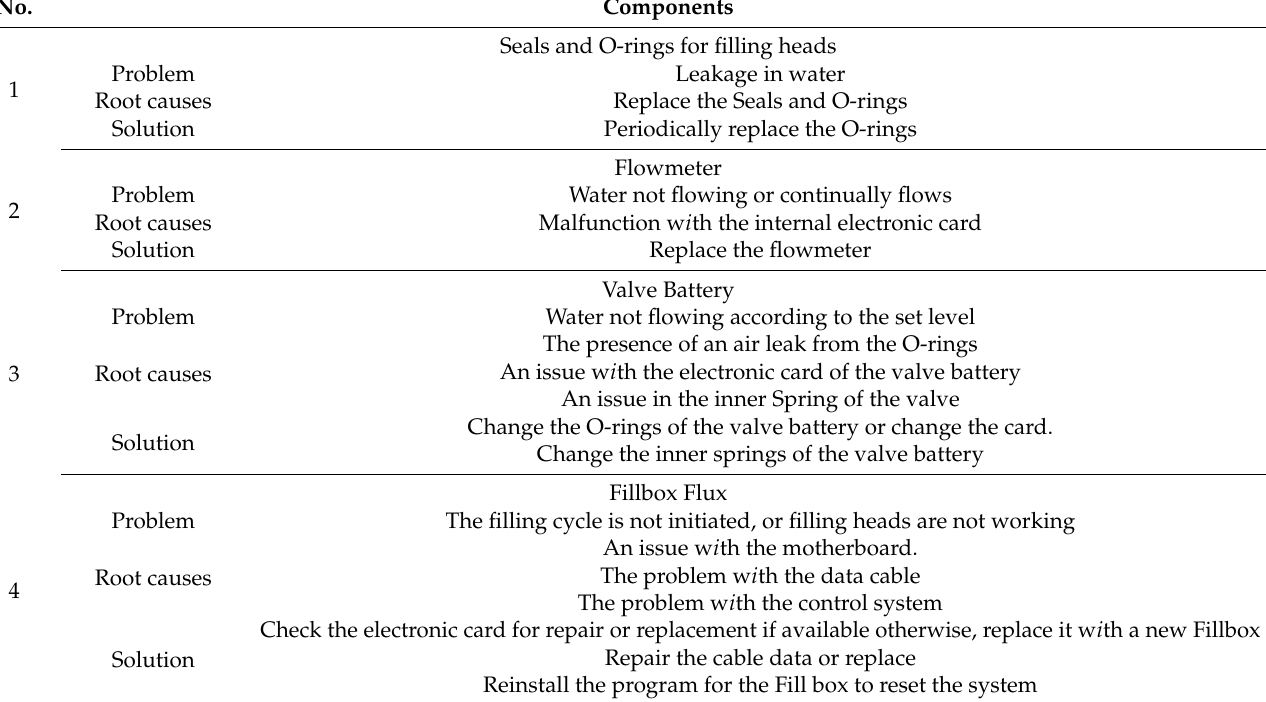
Table 6. The developed maintenance plan for multi-components based on optimal 𝑇 𝑖𝑃𝑀 .